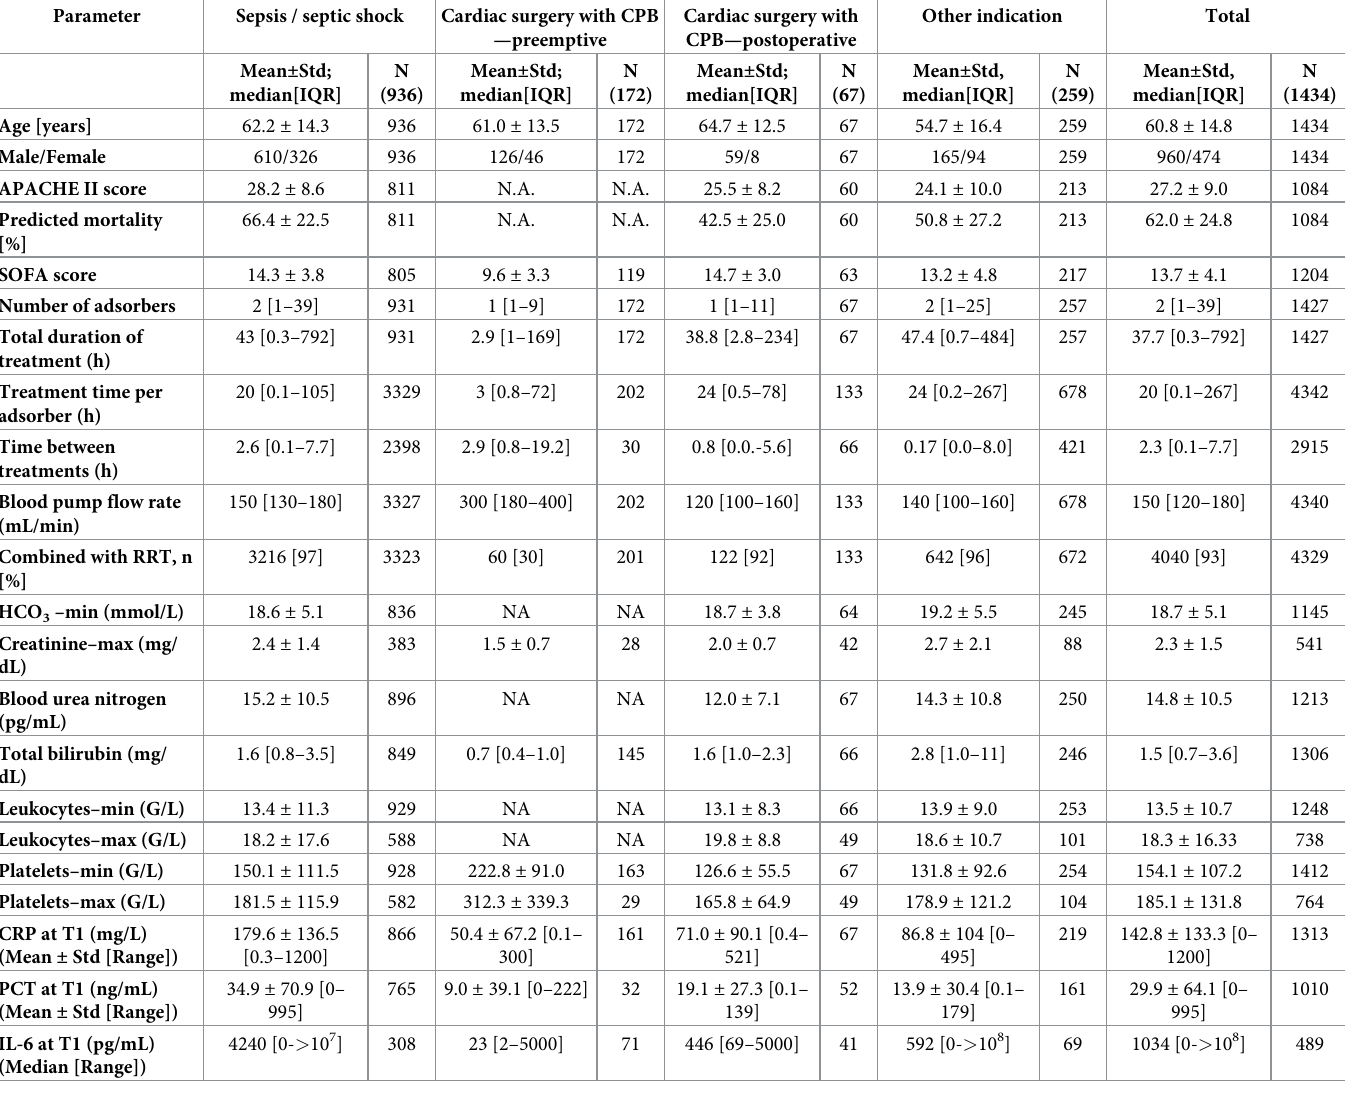
Table 1. Demographics, treatment characteristics and baseline